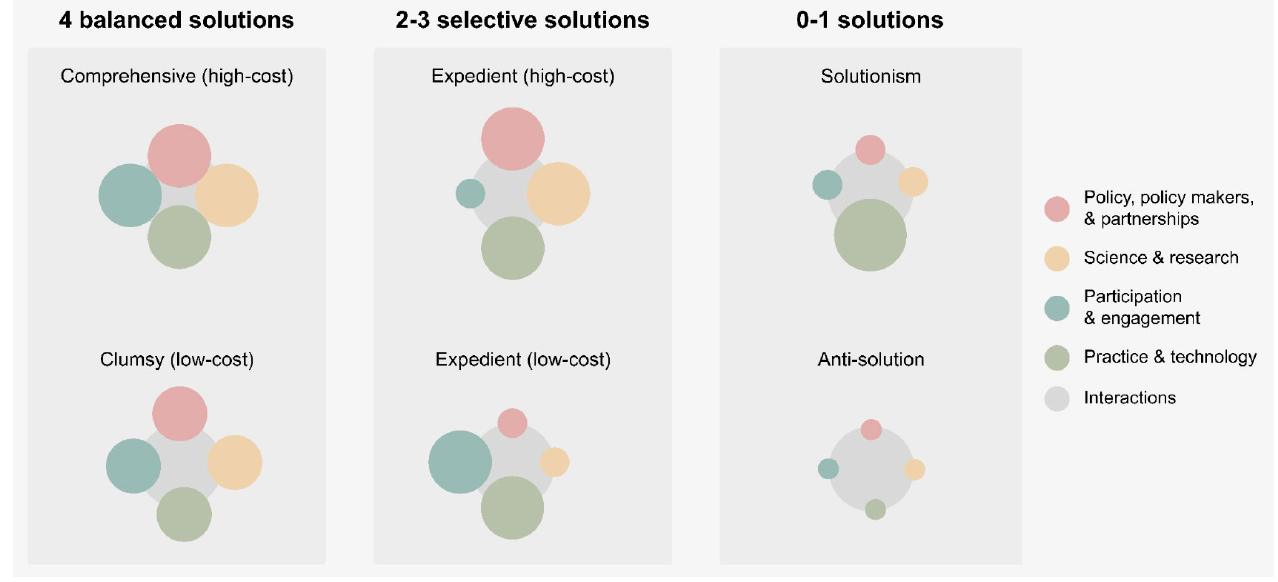
Fig. 2 . Six governance solutionscape expressions for responding to wicked water